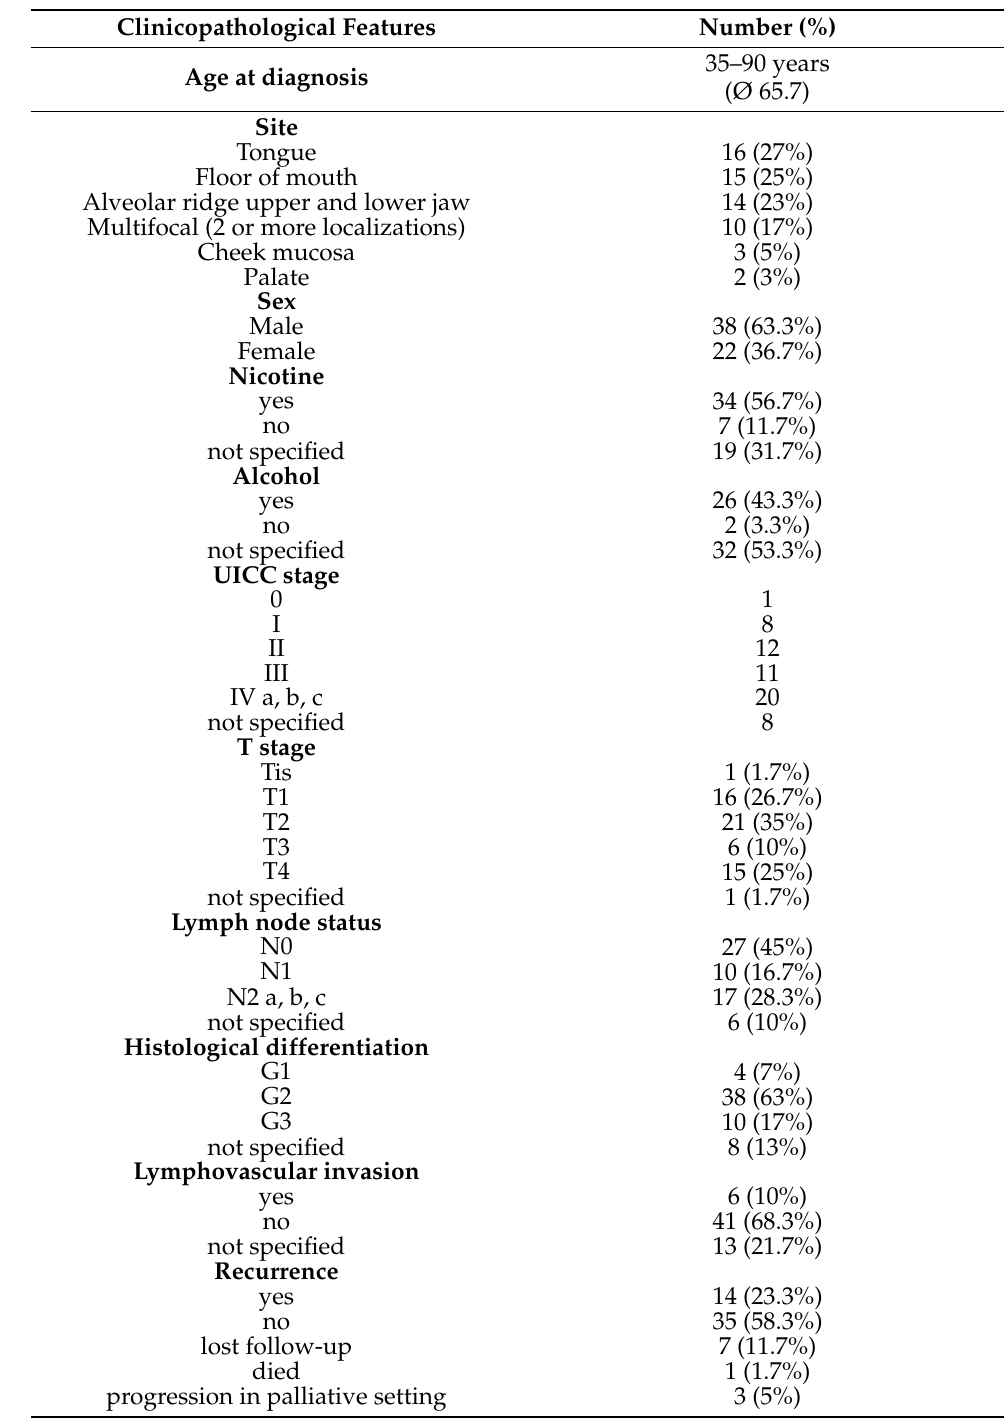
Table 4. Patients’